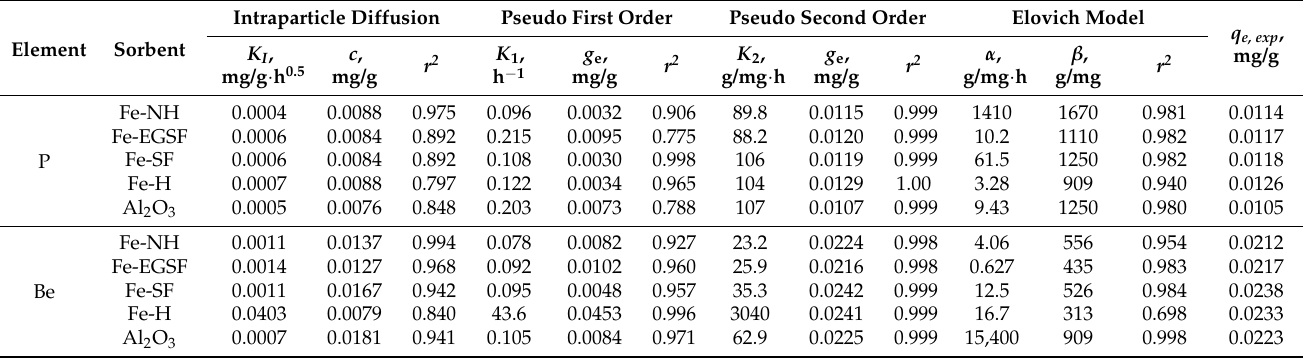
Table 3. The obtained parameters of kinetic